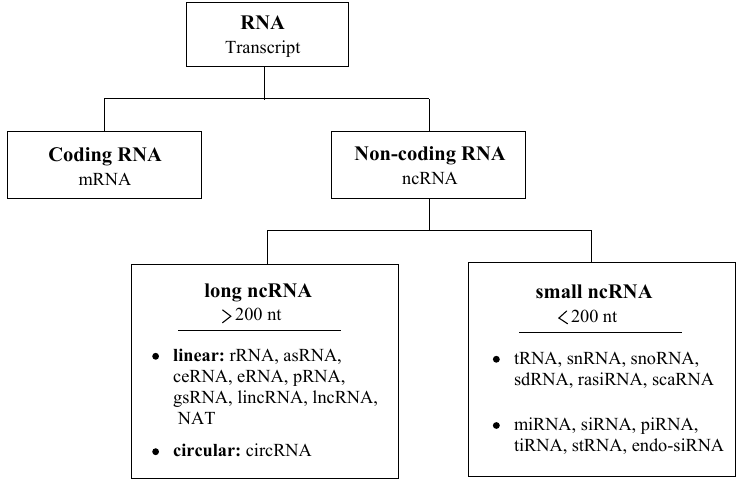
Figure 1. Diagram presenting the RNA